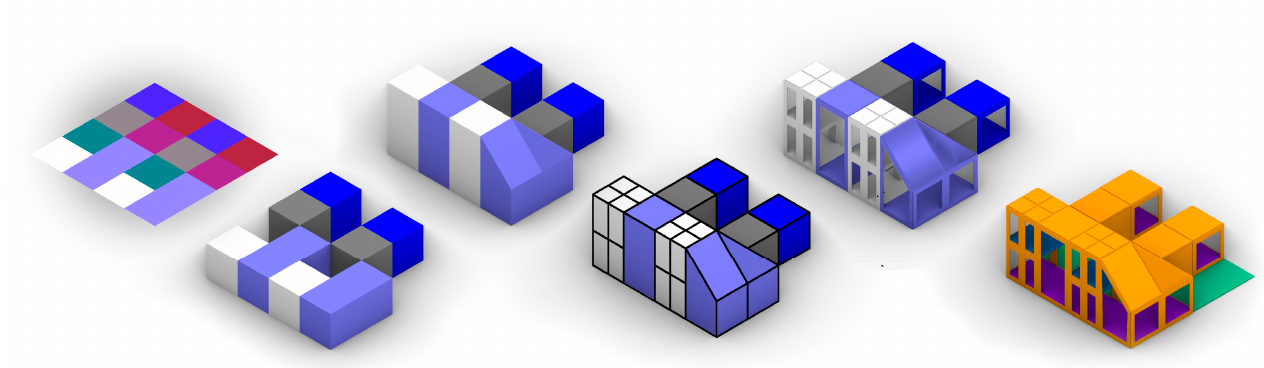
Figure 4. Evolution of the evo-devo model. From left to right: color-pattern (genotype), cells creation based on luminance, allometry (heights) based on red channel, subdivision (tiles) based on green channel, homeotic genes (openings) based on blue channel and final geometry (phenotype). Table 1. Transformations based on color channel and